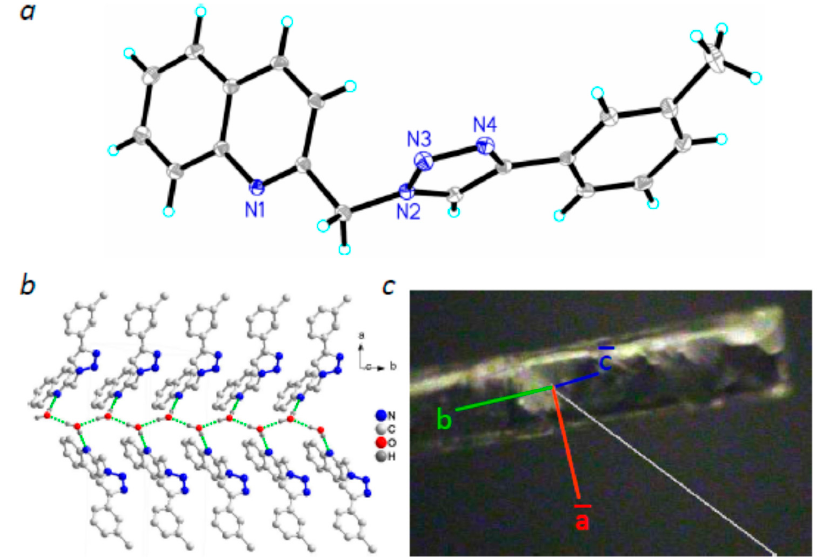
Figure 2. Molecular structure of 2 ( a ). H-bond interactions with lattice water molecules in 2 ( b ). Crystal image with lattice directions of 2 ( c ).